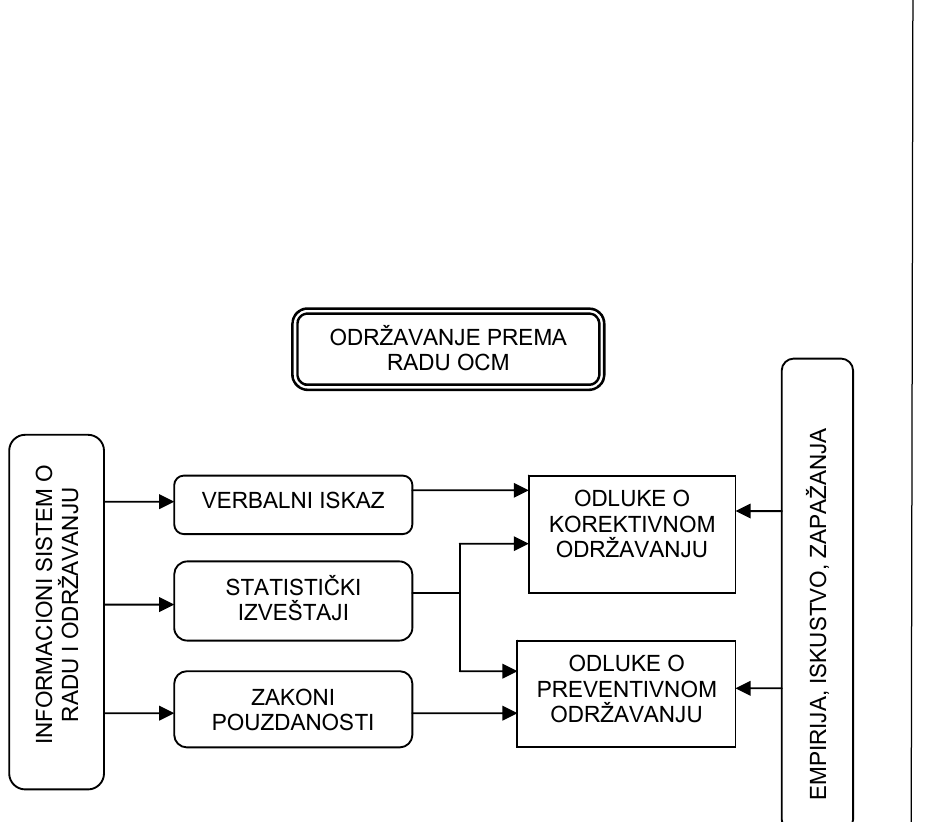
Figure 5 – Shematic model of technical sistem maintenance management by the OCM